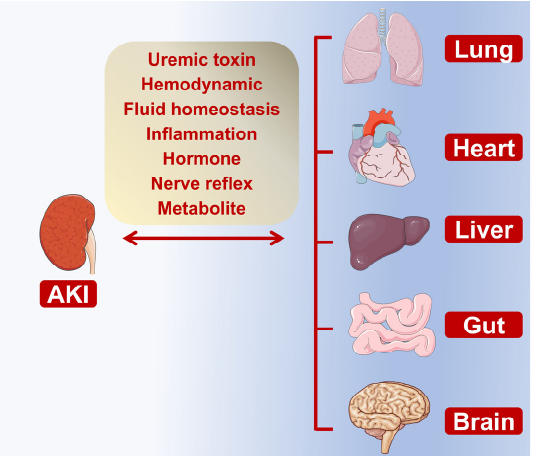
Figure 1. Overview of organ crosstalk during AKI. The crosstalk between kidney and other organs, including lung, heart, liver, gut, and brain, under AKI conditions. The underlying mechanism involves uremic toxin retention, hemodynamic change, fluid homeostasis damage, neuro-hormonal dysfunction, inflammation, and metabolite accumulation. Abbreviations: AKI, acute kidney injury.